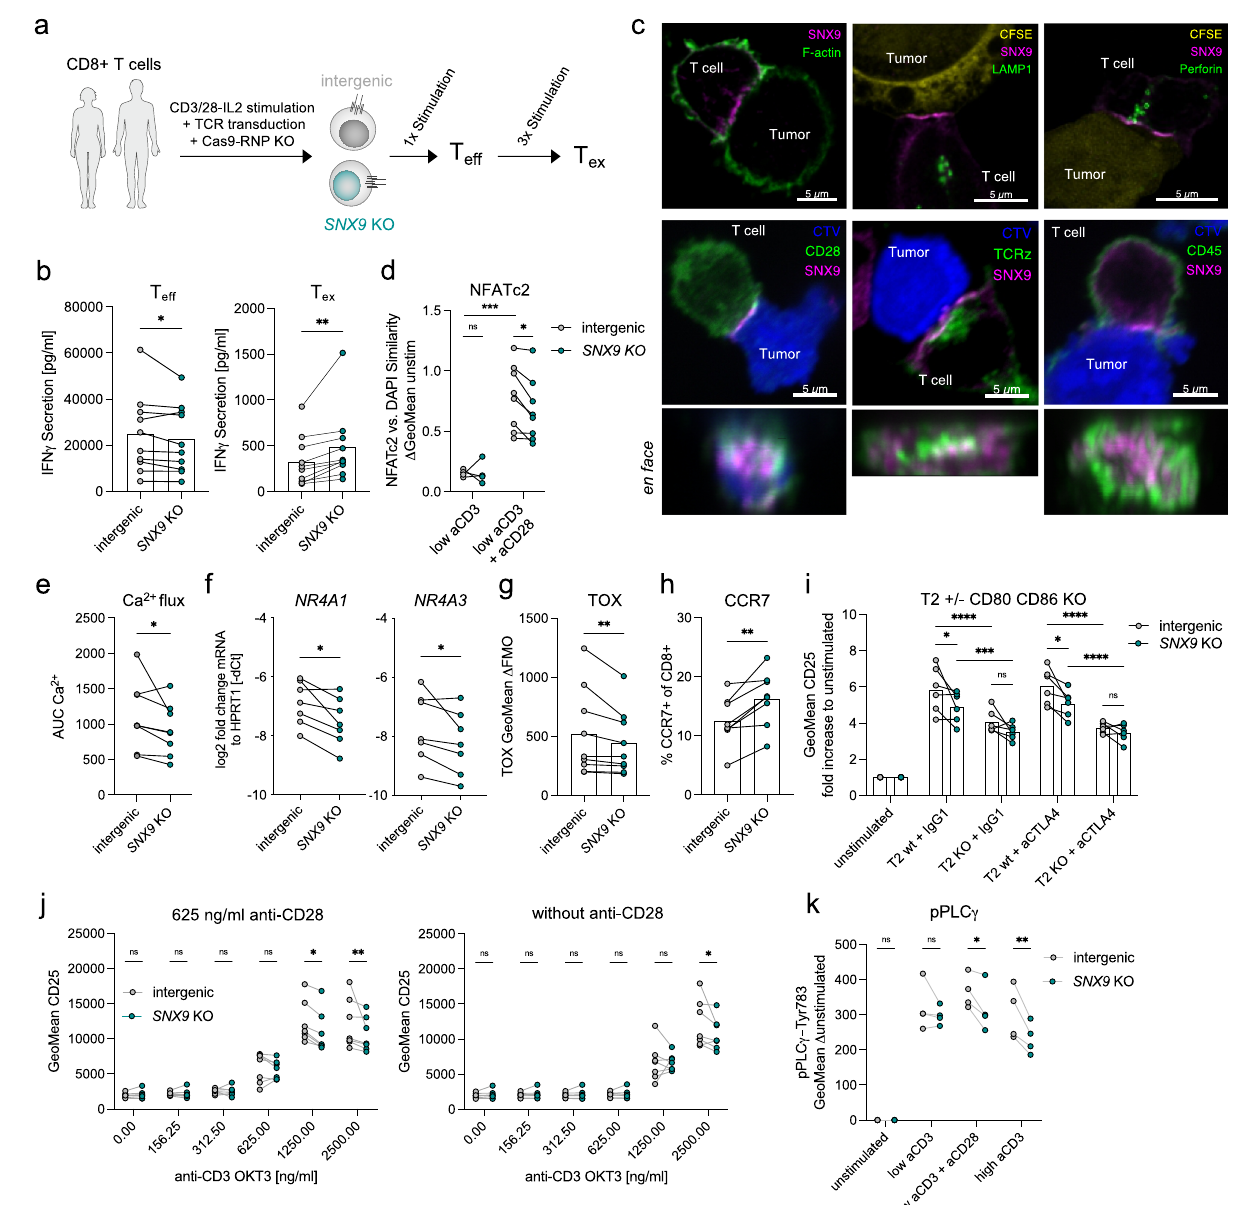
Fig.3| SNX9 KOimproveseffectorfunctionsofexhaustedTcellsanddampens theNFAT-NR4A1/3-TOXaxis.a SchematicproceduretogenerateSNX9KOTcells. b IFN γ secretion by ELISA of T eff and T ex in response to re-stimulation. n =10 donors (T eff ) and 8 (T ex ). c Top row: representative confocal images of T ex co- cultured with T2 tumor cells for actin ( n =6), and LAMP1/Perforin ( n =3). Bottom row:exampleimagesofCD28-EGFP( n =6)orTCRz-EGFP( n =5)fusionproteins,or anti-CD45 ( n =6) and SNX9 in T eff . All images are provided in the Source Data fi le. d NucleartranslocationmeasuredbyimagecytometryofNFATc2inT eff uponanti- CD3/28 stimulation. n =7 donors of n =2 experiments. e Area under the curve (AUC) of Calbryte520-AM Ca 2+ fl ux upon stimulation. n =8 donor of n =3 experi- ments. f RT-qPCR quanti fi cations of mRNA for NR4A1 and NR4A3 in cells on day 6 of the T ex culture. n =7 donors of n =2 experiments. g Antibody staining (delta